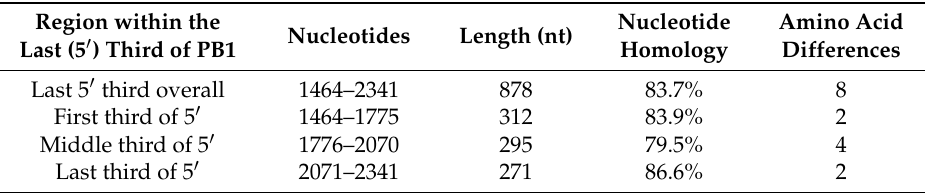
Figure 5. Structure of 5 ′ chimeric PB1 plasmids. Schematic representation of 5 ′ chimeric PB1 plasmid constructs showing the origin of each section of the gene; orange represents PR8 (P) and blue represents Udorn (U) sequences. In the nomenclature for the chimeras, uppercase indicates the origin of the larger thirds of the PB1 (all PR8); lowercase indicates the origin of the smaller three sections of the last third of the PB1. The nucleotide length and boundaries of each 5 ′ section is indicated. Table 2 summarises the location, length, nucleotide homology and amino acid differences between PR8 and Udorn in respect to the three sections within the 5 ′ third of the chimeric PB1 genes. Eight of the 25 amino acid differences across the entire PR8 and Udorn PB1 proteins occur in the last third of the gene. At the nucleotide level the last third of the PB1 gene showed 83.7% homology between PR8 and Udorn viruses. Table 2. Nucleotide homologies and amino acid differences between Udorn PB1 and PR8 PB1 in the 5 ′ third.